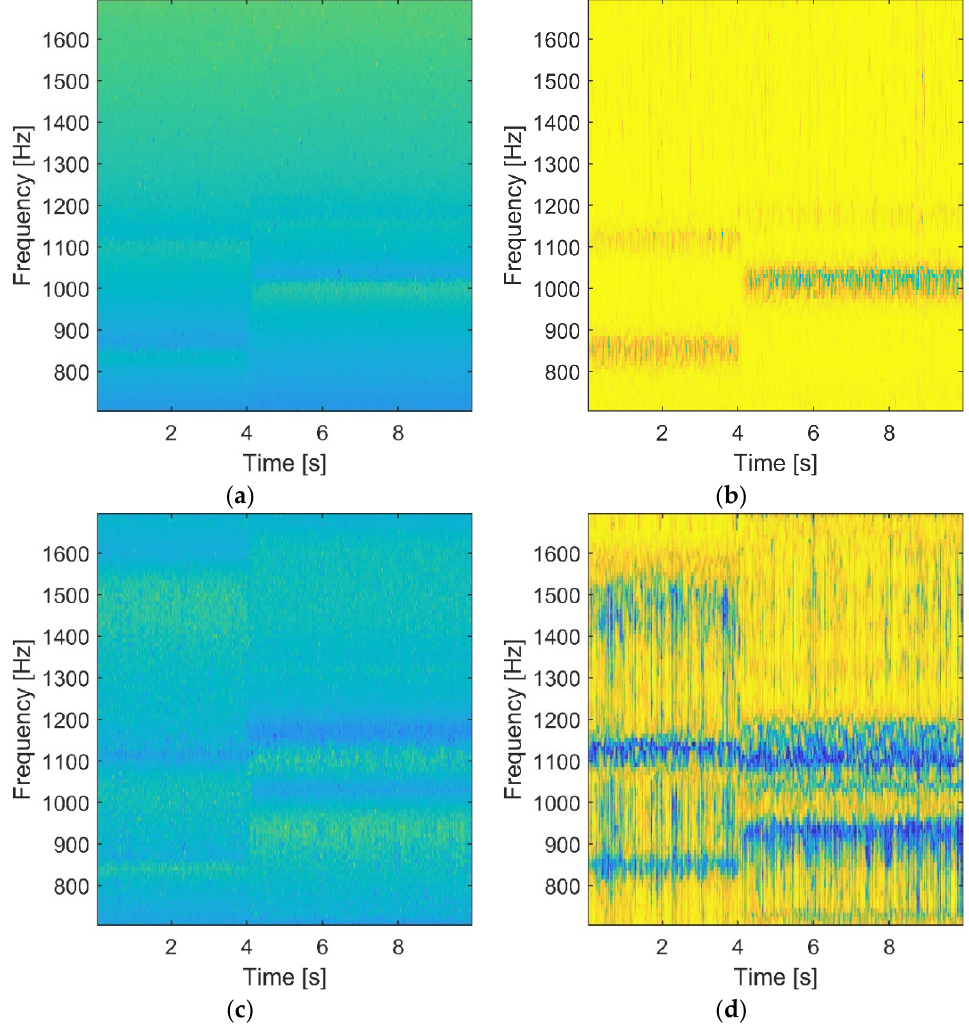
Figure 6. Wavelet-based analysis for the frame structural element: ( a ) wavelet-based FRF in a logarithmic scale; ( b ) wavelet-based FRF coherence; ( c ) wavelet-based transmissibility; ( d ) wavelet-based transmissibility coherence.